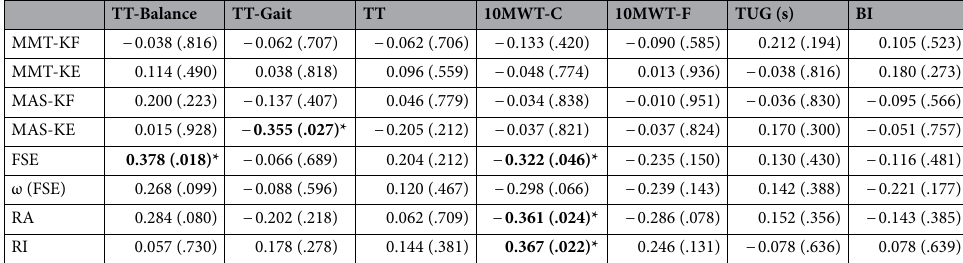
Table 4. Two-tailed partial correlation controlling for Brünnstrom recovery stage. § MMT manual muscle test; KF knee flexor; KE knee extensor; MAS modified Ashworth Scale; FSE first swing excursion; ω(FSE) angular velocity of first swing excursion; RA resting angle of the pendulum test; RI relaxation index; TT Tinetti test; TT-Balance balance section of TT; TT-Gait Gait section of TT; 10 MWT 10-m walk test; 10MWT-C comfortable speed of 10 MWT; 10MWT-F the fastest speed of 10 MWT; TUG timed-up-and-go test; BI Barthel index. *Correlation is significant at 0.05 level. a The MMT, MAS, and pendulum tests were investigated in the paretic knees (N = 40). b The strength of the linear relationship is presented by the correlation coefficient r . p values are given in